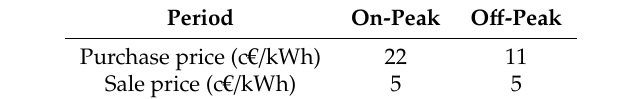
Table 2. Costs, in c€/kWh, of the electricity for the residential electricity tariff considered. Period